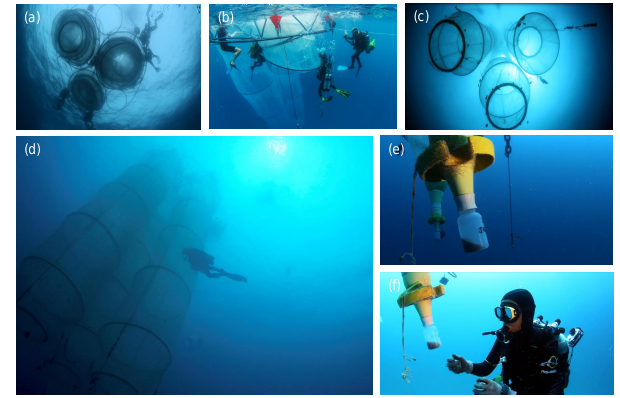
Figure 2. View of the experiment from the side and the seafloor during (a–c) and after the deployment (d) . Panels (e, f) : collec- tion of sediment traps by the scuba divers (photos: J. M. Boré and E. Folcher, Figure 1.